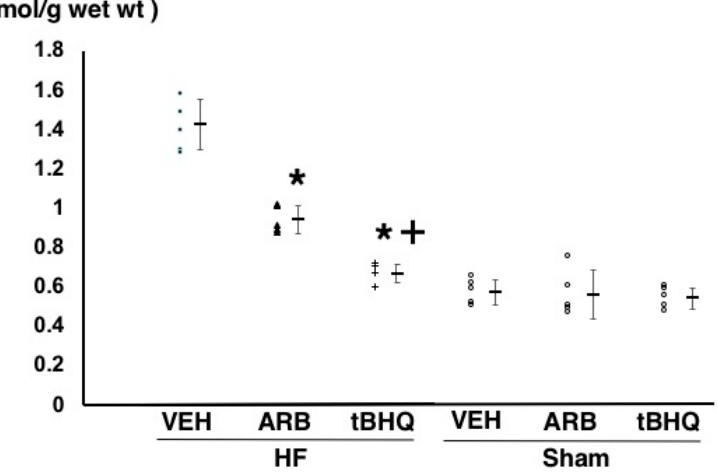
Figure 6. The amount of thiobarbituric acid-reactive substances in the rostral ventrolateral medulla of heart failure treated with intracerebroventricular (ICV) infusion of vehicle (HF-VEH), or with ICV infusion of angiotensin II type 1 receptor blocker (HF-ARB), or with ICV infusion of nuclear factor erythroid 2-related factor 2 activator, tert -butylhydroquinone (HF-tBHQ), or sham treated with ICV infusion of VEH, or with ICV infusion of ARB, or with ICV infusion of tBHQ. n = 5 for each group. All data are shown in dot plot and mean ± standard deviation. * p < 0.05 vs. HF-VEH in HF-ARB and HF-tBHQ. + p < 0.05 vs. HF-ARB in HF-tBHQ.